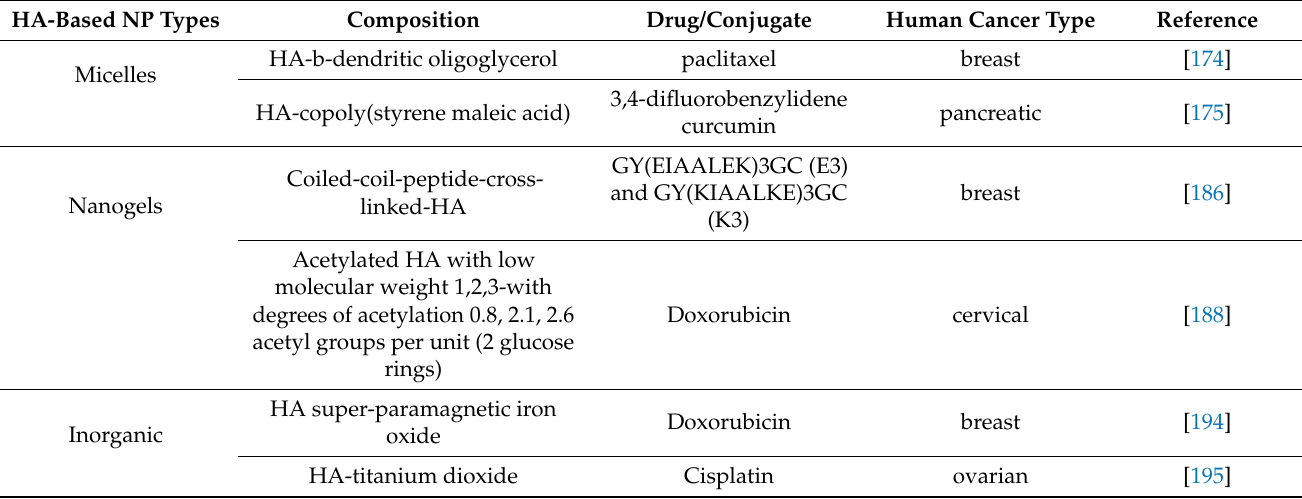
Table 2. Types of HA-based nanoparticles tested in different cancer